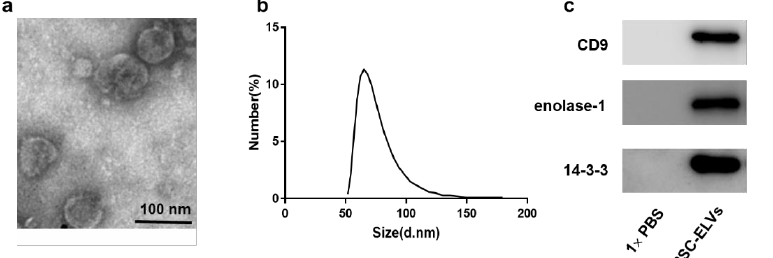
Figure 1. Identification of E. granulosus protoscoleces-derived exosome-like vesicles (PSC-ELVs). ( a ) Images of the rounded or cup-shaped PSC-ELVs under transmission electron microscopy (TEM). Scale bars: 100 nm; ( b ) The size distribution of the PSC-ELVs. ( c ) Western blotting analysis of CD9, enolase-1, and 14-3-3 in PSC-ELVs.